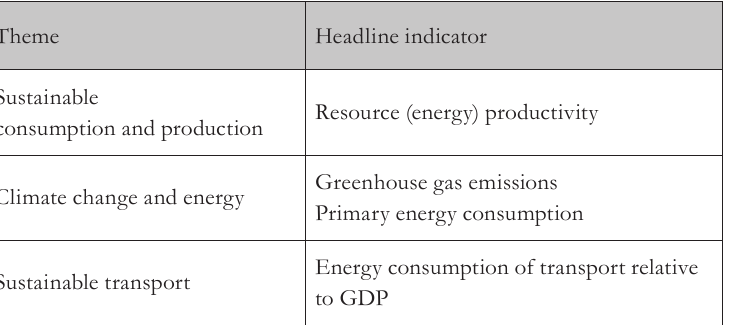
Tab. 1 – Sustainable Development Indicators. Source: Sustainable Development